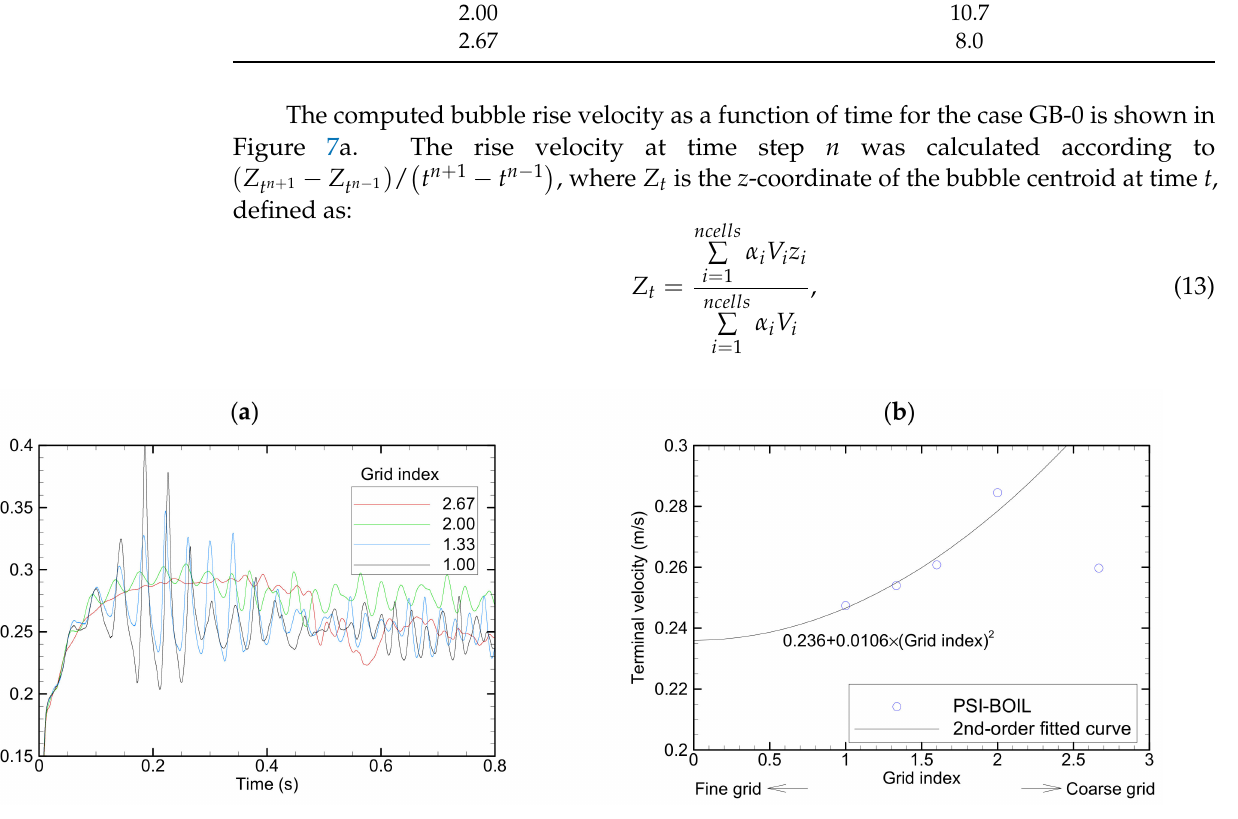
Figure 7. Grid dependency study for Case G-B0: evolution of the rise velocity ( a ), and the grid dependency of the terminal velocity ( b